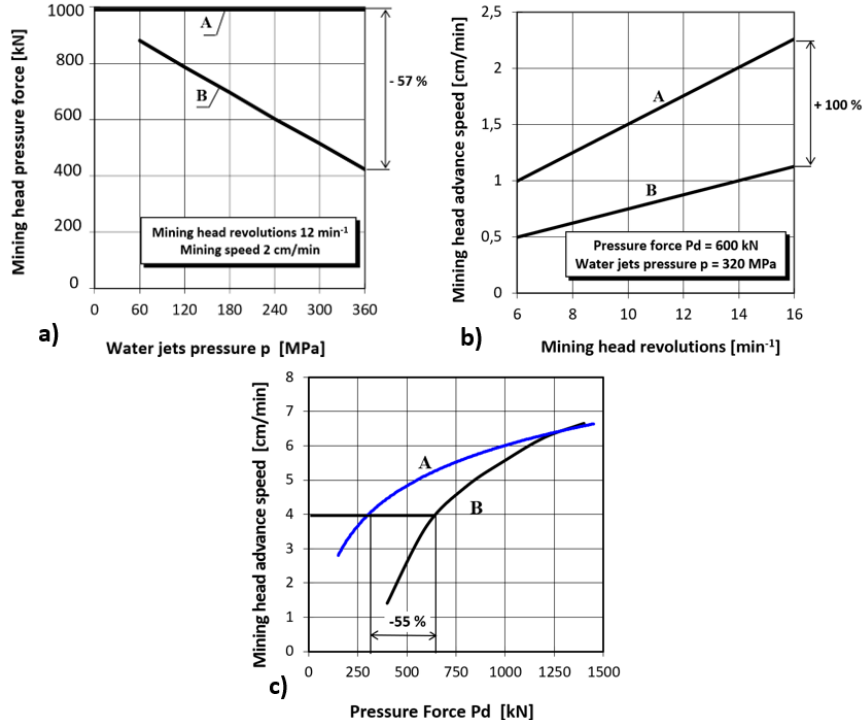
Figure 8. Influence of: ( a ) the pressure of water jets supporting the mining process on the value of the head pressure force: ( b ) the number of head revolutions on the machine advance speed, ( c ) the value of the pressure force on the machine advance speed [6]; A—without HPW assistance, B—with HPW assistance.